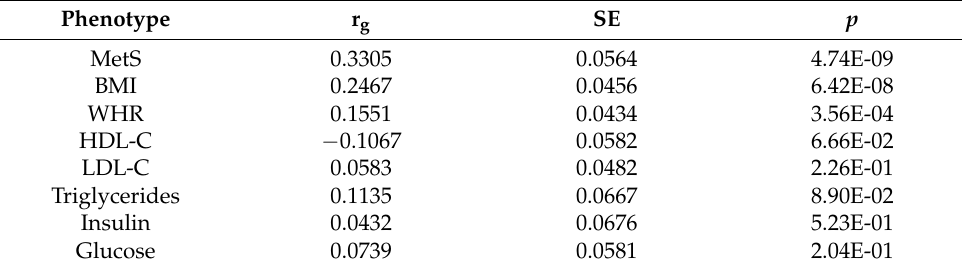
Table 2. Genetic correlation estimates between PTSD and metabolic traits.